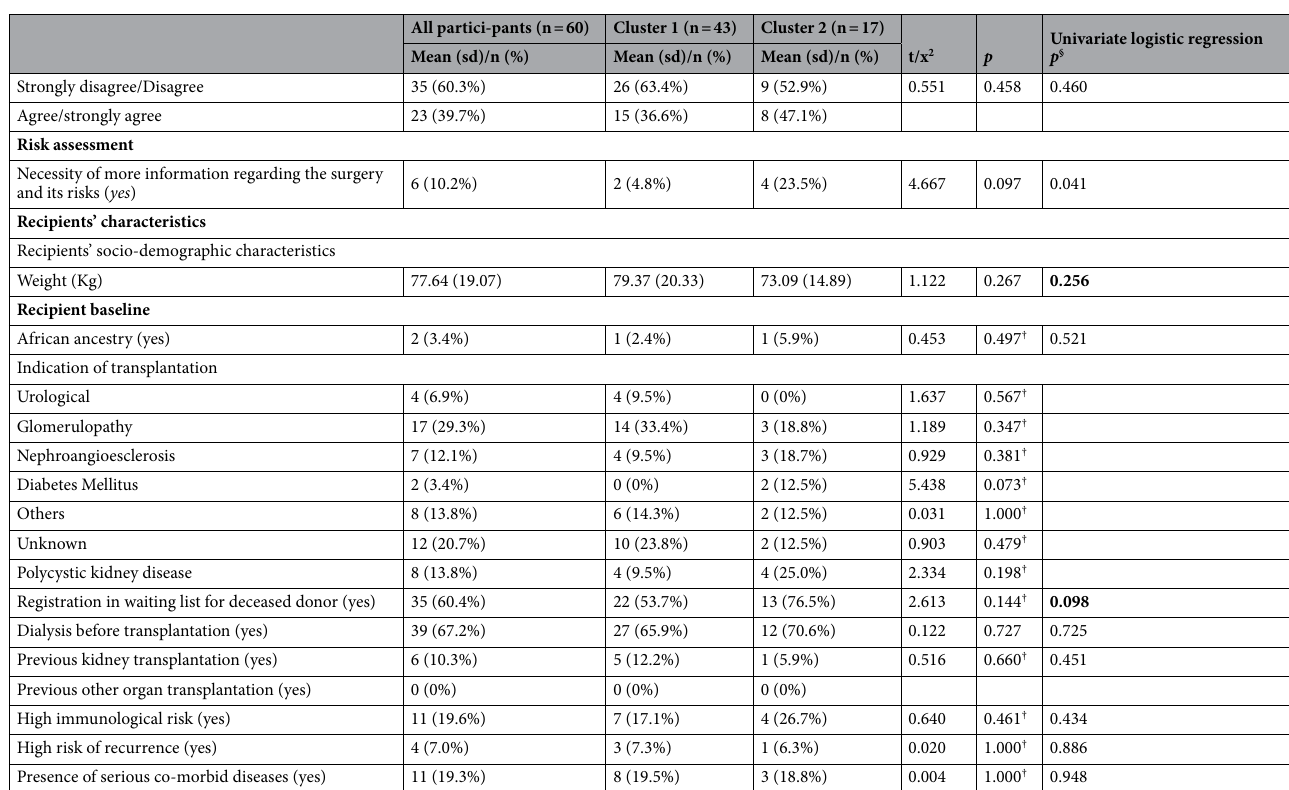
Table 2. Pre-donation characteristics and differences between clusters. † Fisher’s exact test. ‡ Not assuming equality of variances. § Any p-value remained statistically significant after FDR correction. ¶ SF-36 T scores (> 55 is higher than average, < 45 is lower than